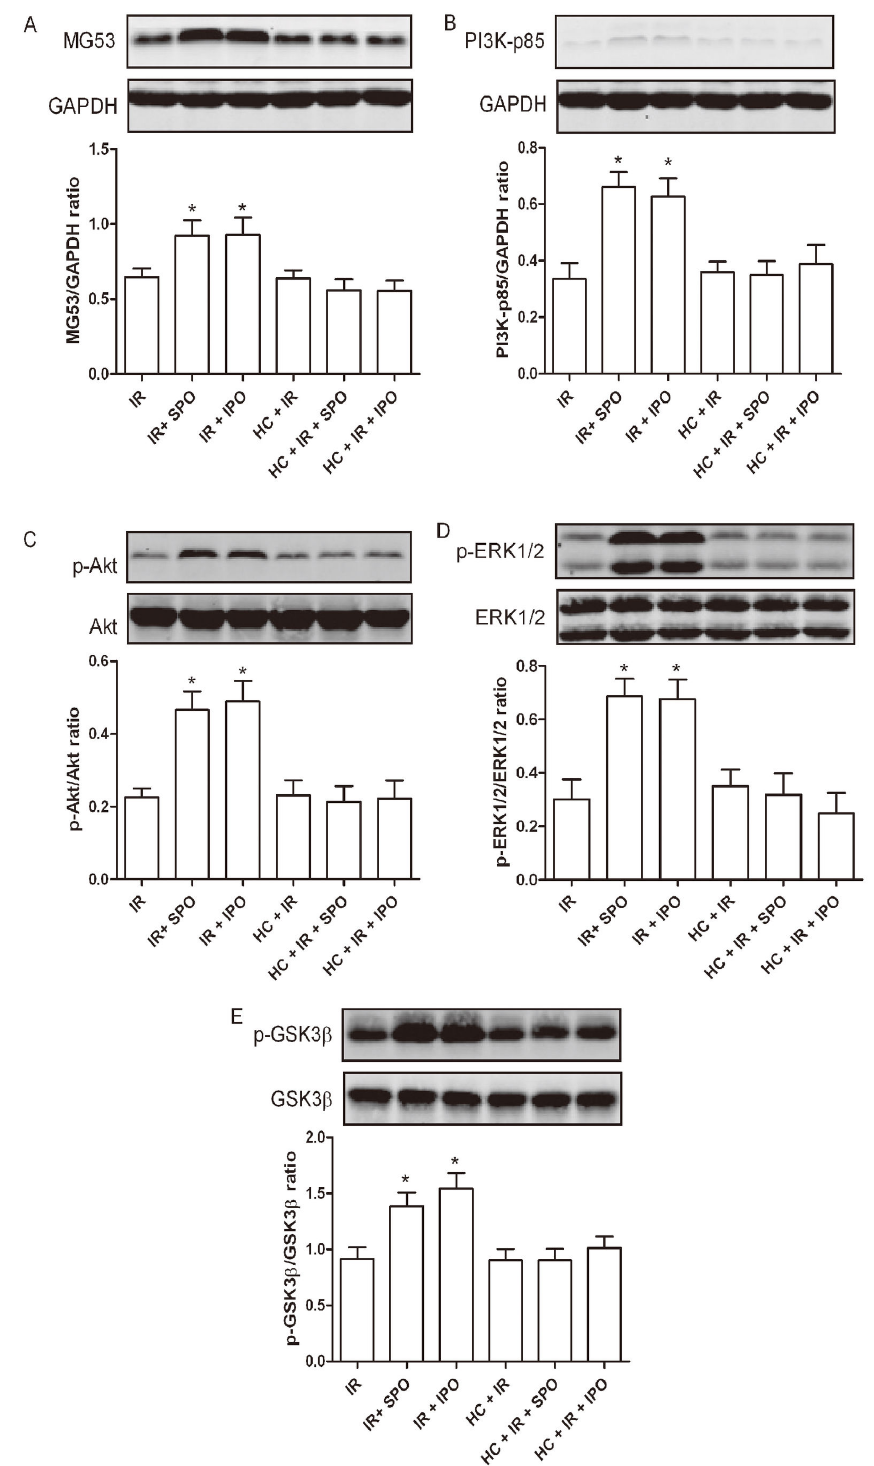
Figure 4. Effects of sevoflurane and ischemic postconditioning on the expression of MG53 (A), PI3K-p85 (B), p-Akt (C), p- ERK1/2 (D), p-GSK3β (E) in rat hearts exposed to ischemia-reperfusion (IR). IR: ischemia reperfusion; SPO: sevoflurane postconditioning; IPO: ischemic postconditioning; HC: hypercholesterolemia. Data are mean ± SD, n = 6 hearts/group. * P < 0.05 vs . IR. doi: 10.1371/journal.pone.0076652.g004 PLOS ONE |